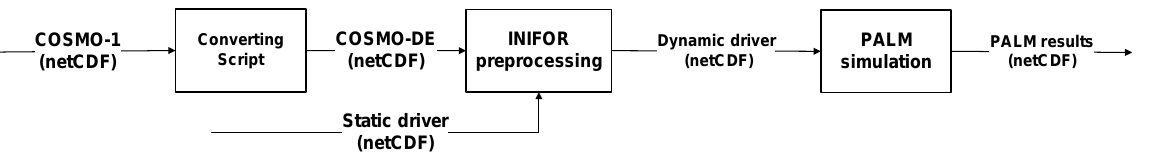
Figure 3. Simulation workflow of mesoscale